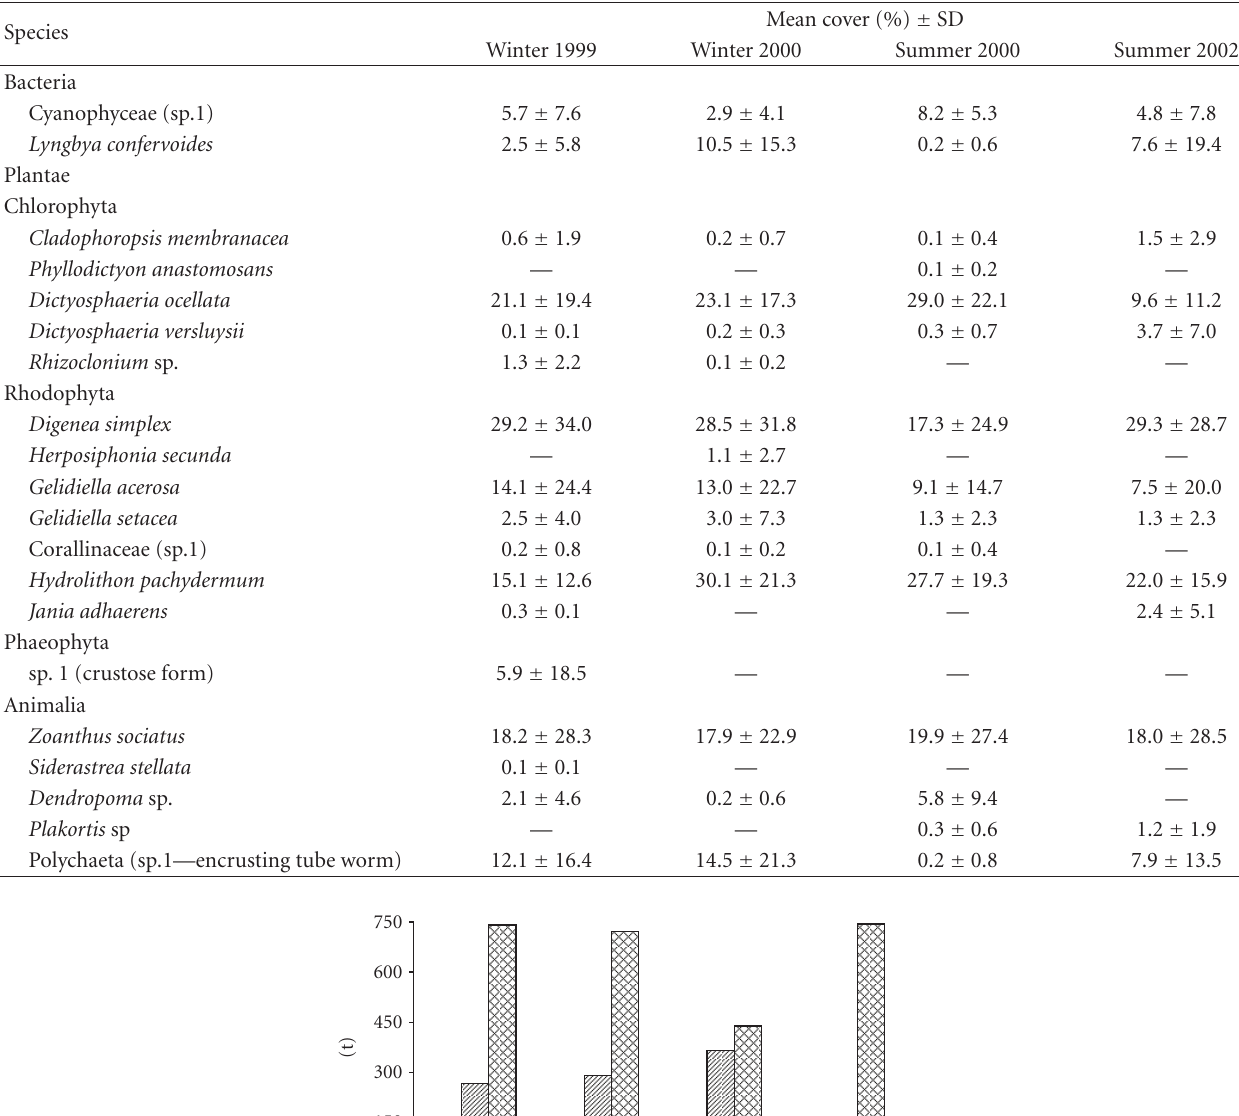
Table 1: Mean cover of benthic species recorded in Atol das Rocas reef flat. The values correspond to the mean of the 10 sites sampled. Algae nomenclatures are in accordance with AlgaeBase (2009). Other species in accordance with Catalogue of Life (2009).